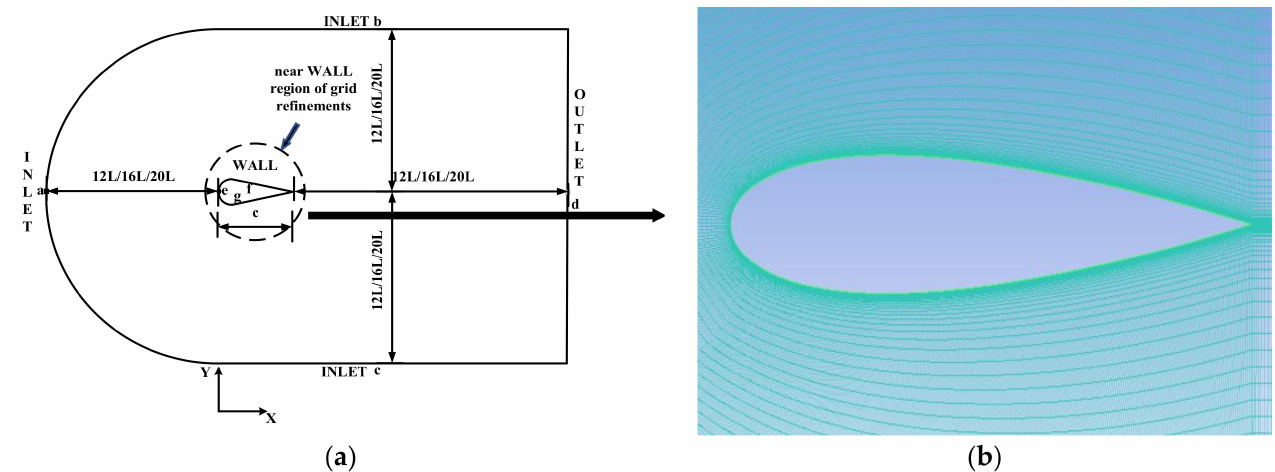
Figure 4. ( a ) Computational domain; ( b ) close view of grids near the WALL region.